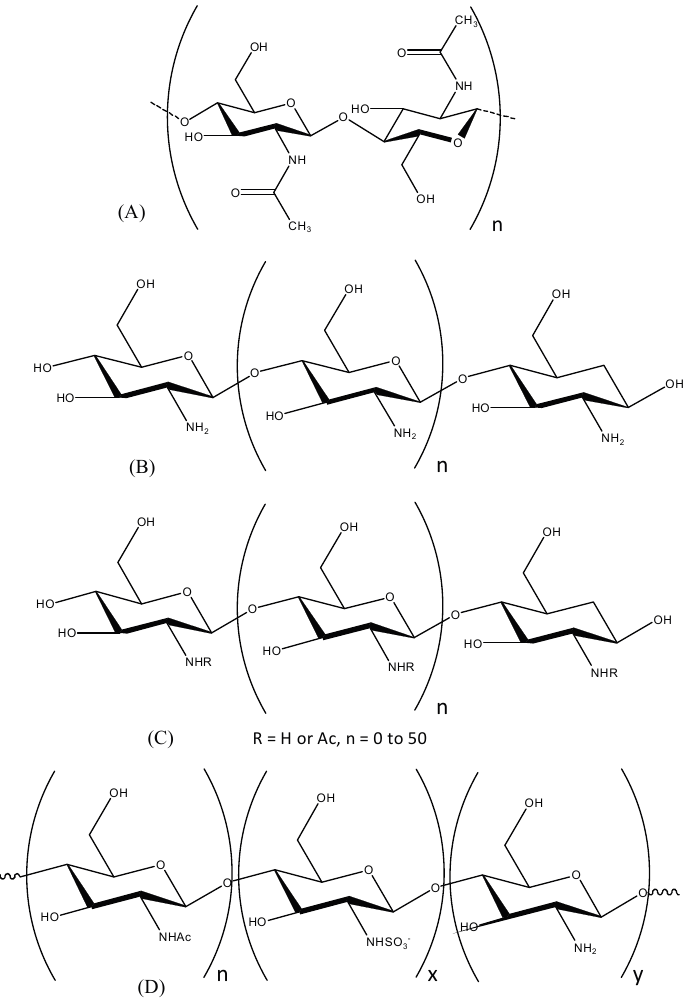
Figure 1. Chemical structure of ( A ) chitin; ( B ) chitosan; ( C ) chitooligosaccahrides; ( D ) sulfated chitosan